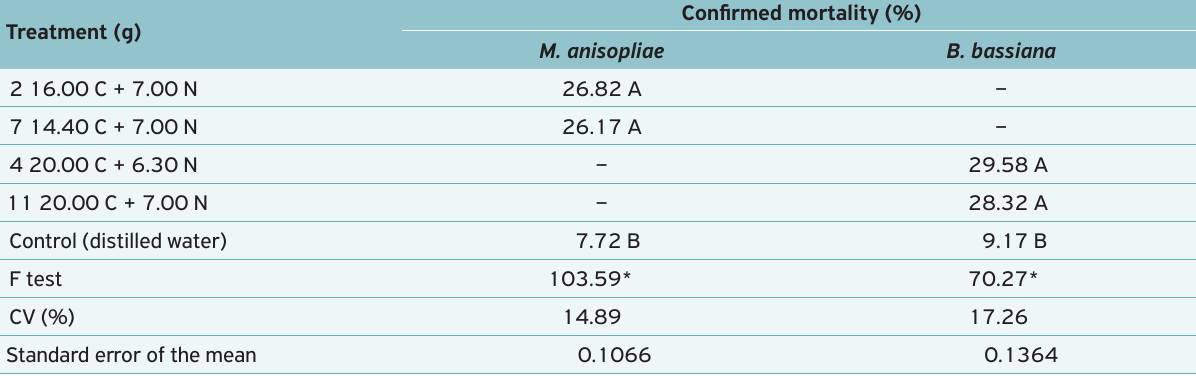
Table 7. Confirmed mortality (%) of third-instar larvae ( Diatraea saccharalis ) at eight days after the application of different suspensions of Metarhizium anisopliae and Beauveria bassiana , obtained from liquid culture media (blastospores) in different concentrations of nitrogen and carbon (temperature at 26 ± 1°C, RH 70 ± 10% and 12-hour photophase).